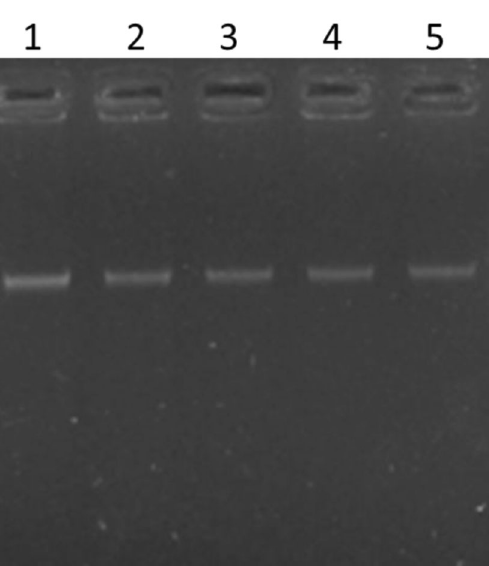
Figure 4. Agarose gel electrophoresis analysis of DNA. Total DNA was extracted from algal cells treated with DMSO (lane 1) or with 30 μ g/mL PG for 12 h (lane 2), 24 h (lane 3), 48 h (lane 4) and 72 h (lane 5), and loaded onto 1% agarose